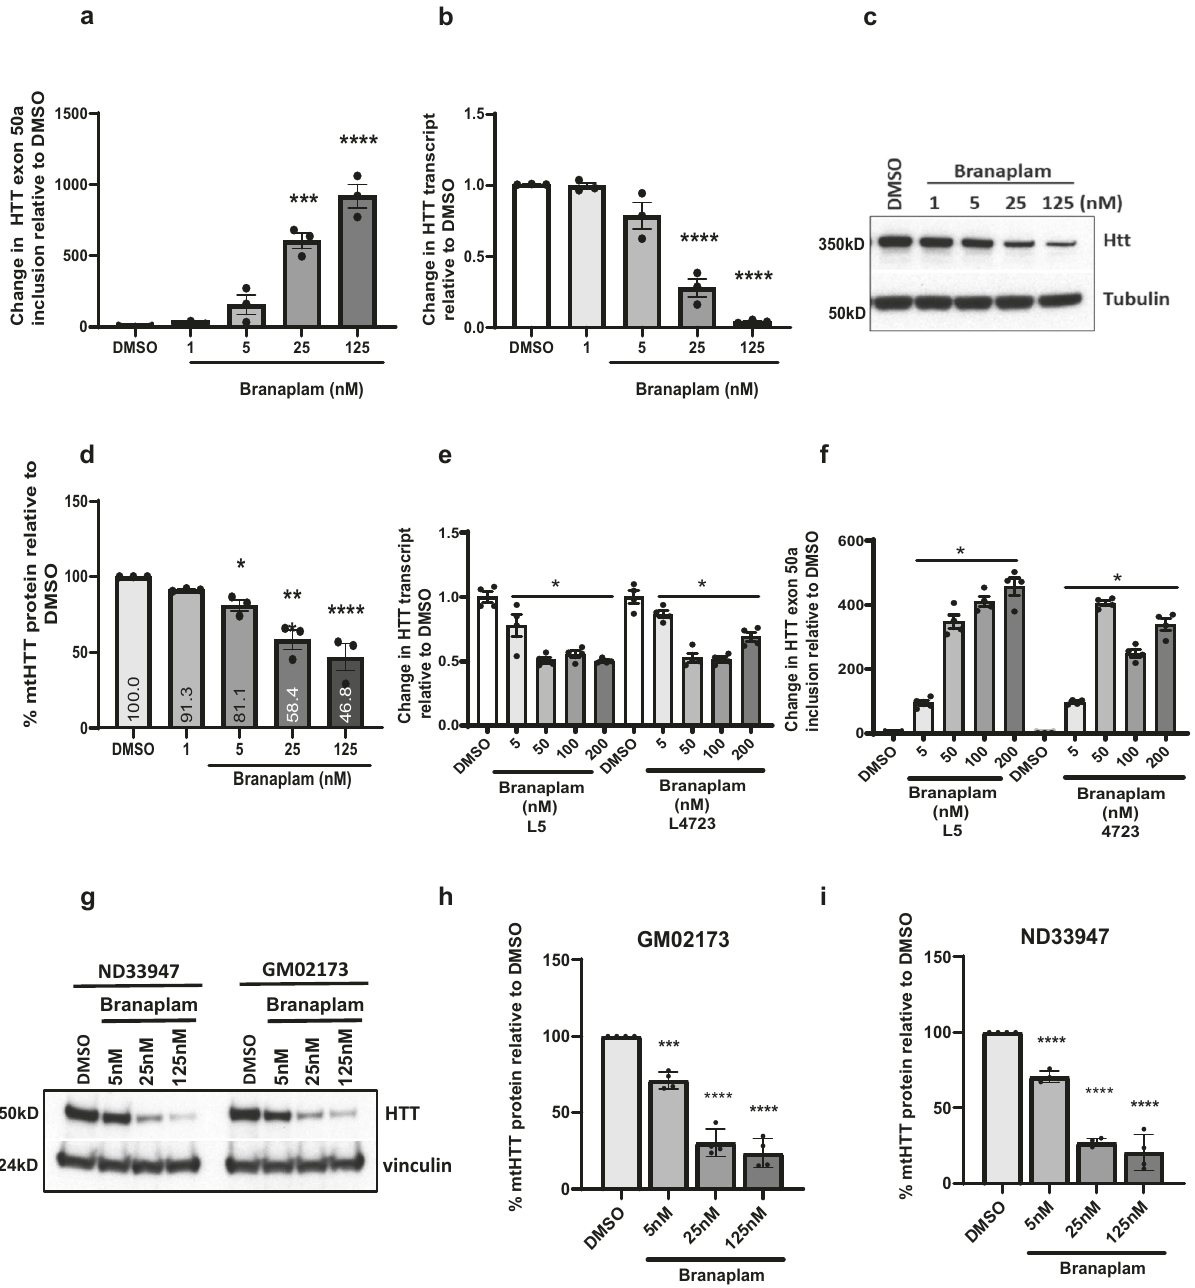
Fig. 3 Branaplam lowers HTT-transcript and protein levels in normal and HD patient cells. a Quantitative PCR results showing the transcript levels of HTT exon 50a included after DMSO or branaplam treatment (at indicated doses), **** P < 0.0001, one-way ANOVA. The data are presented as mean ± SEM of three independent experiments. b HTT-transcript changes after DMSO or branaplam treatment (at indicated doses) for 24 h in SH-SY5Y human neuroblastoma cells, *** P < 0.001, **** P < 0.0001, one-way ANOVA. The data are presented as mean ± SEM of three independent experiments. c Western blot and d quantitation showing total HTT protein levels after DMSO or branaplam treatment (at indicated doses) for 48 h in SH-SY5Y cells, * P < 0.05, *** P < 0.001, **** P < 0.0001, one-way ANOVA. The data are presented as mean ± SEM of three independent experiments. e Quantitative PCR results showing HTT mRNA expression levels after DMSO or Branaplam treatment (at indicated doses) for 24 h. Two independent HD patient fi broblasts cell lines (GM04723 and ND31551 (L5)), and a TaqMan ™ assay priming for human HTT exons 64 – 65 was used. Samples are normalized to human GAPDH, and data are the mean ± SEM relative to HD fi broblasts treated with DMSO (eight biological replicates, * P value <0.001, one-way ANOVA followed by a Bonferroni ’ s post hoc). f Quantitative PCR results showing HTT50a exon inclusion levels in two HD patient fi broblasts cell lines (GM04723 and ND31551 (L5)) after 24-h treatment with DMSO or branaplam (at indicated doses). Samples are normalized to human GAPDH, and data are the mean ± SEM relative to HD fi broblasts treated with DMSO (four biological replicates, * P value <0.001, one-way ANOVA followed by a Bonferroni ’ s post hoc). g western blot and h , i quantitation showing mutant HTT protein levels after DMSO or branaplam treatment (at indicated doses) for 96 h in HD patient fi broblast cells, **** P < 0.0001, one-way ANOVA. Data are the mean ± SD relative to DMSO from four independent